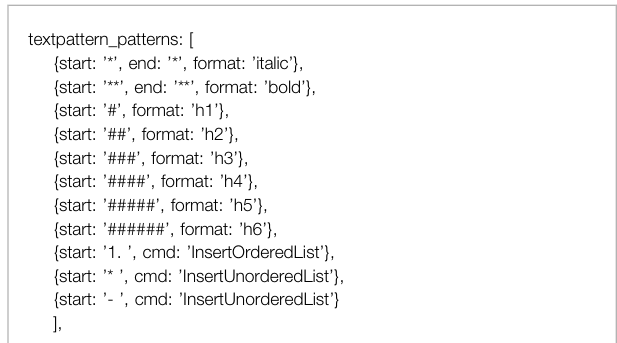
Figure 4 . The markdown language has gained popularity in